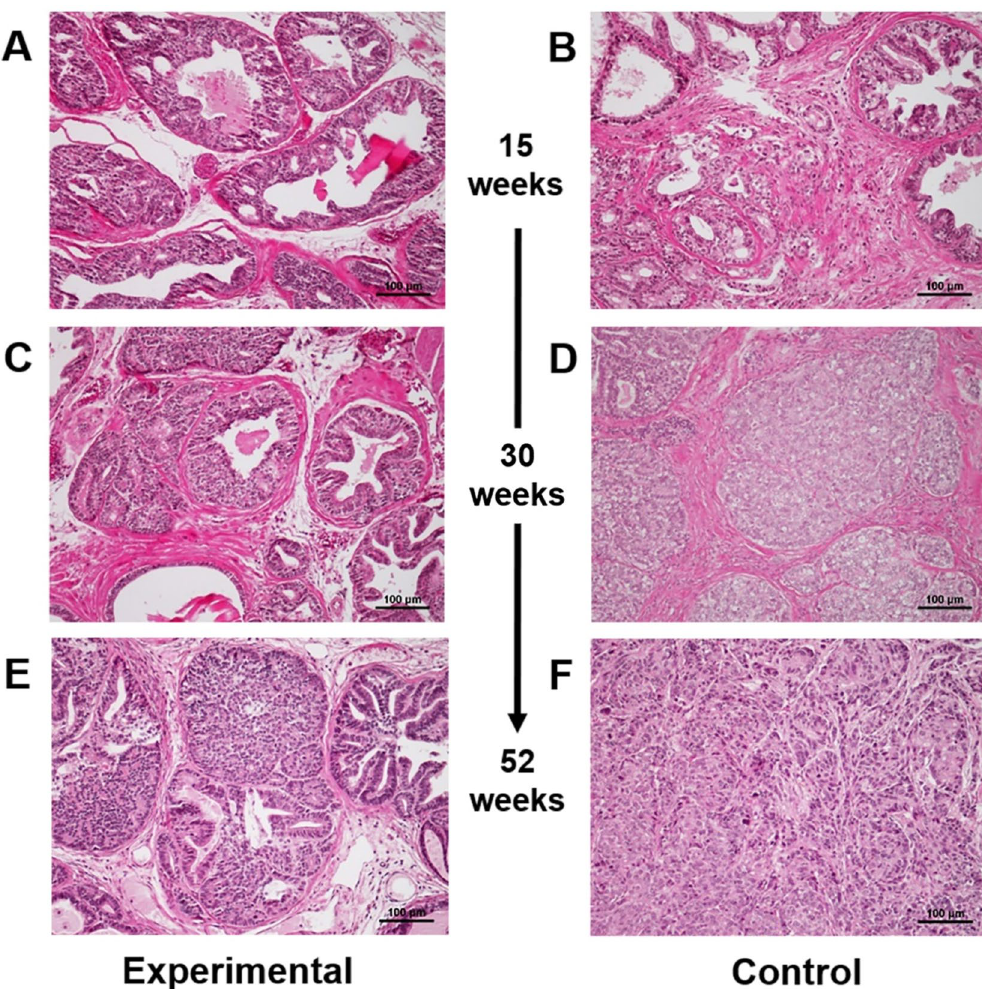
Figure 2. Hematoxylin and eosin-stained tissues at 15, 30, and 52 weeks of age in experimental ( A , C , and E , respectively) and control mice ( B , D , F , respectively). Magnification ×